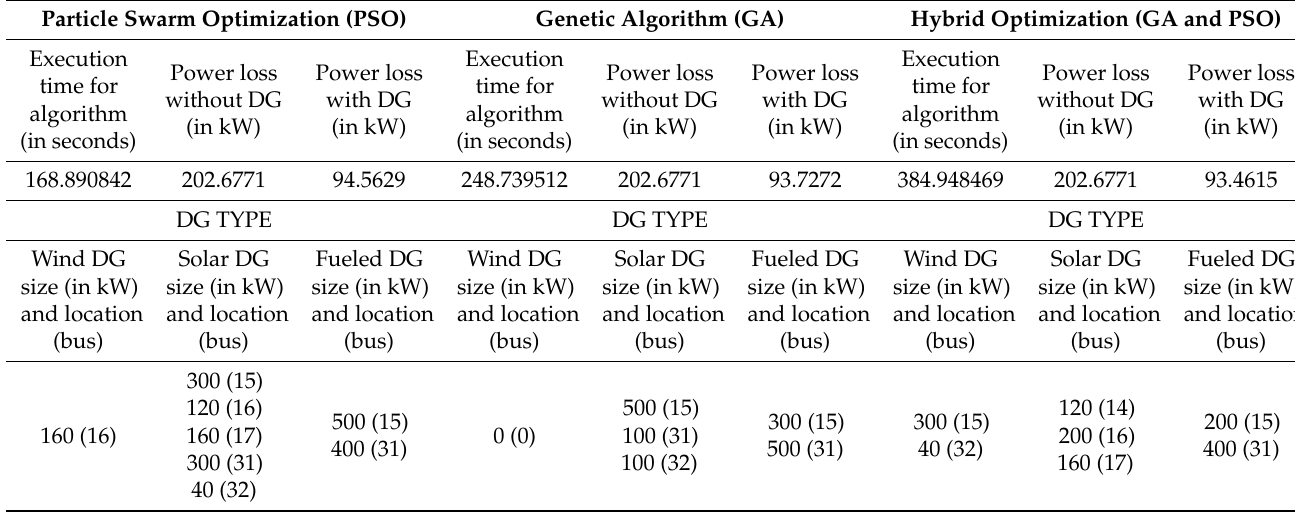
Table 9. Results for optimal DG sizes and their corresponding optimum location using by PEM for scenario-3 using different metaheuristic optimization techniques.